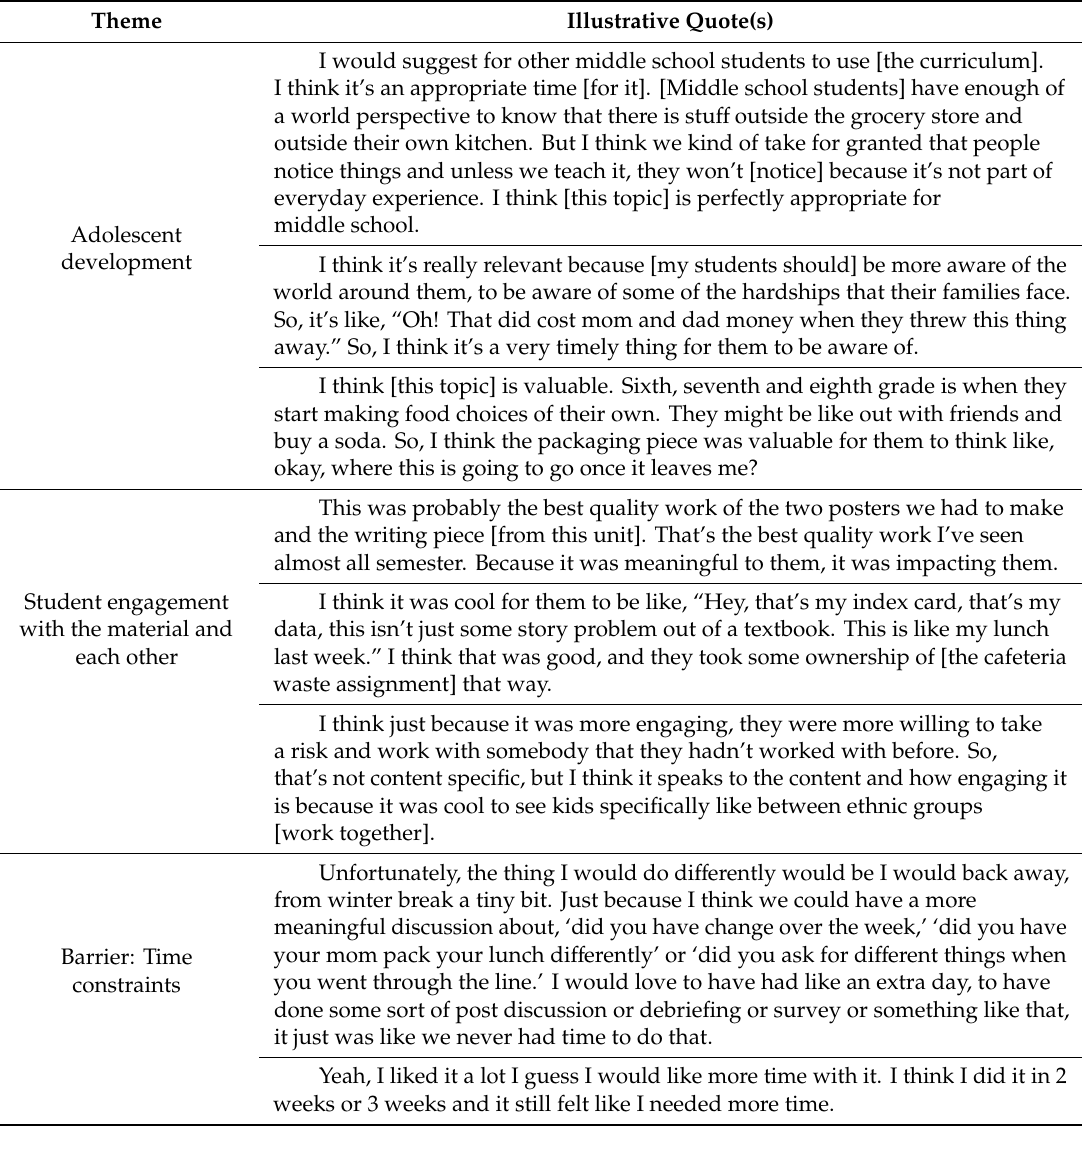
Table 3. Middle School Teacher Interview Theme Results ( n =